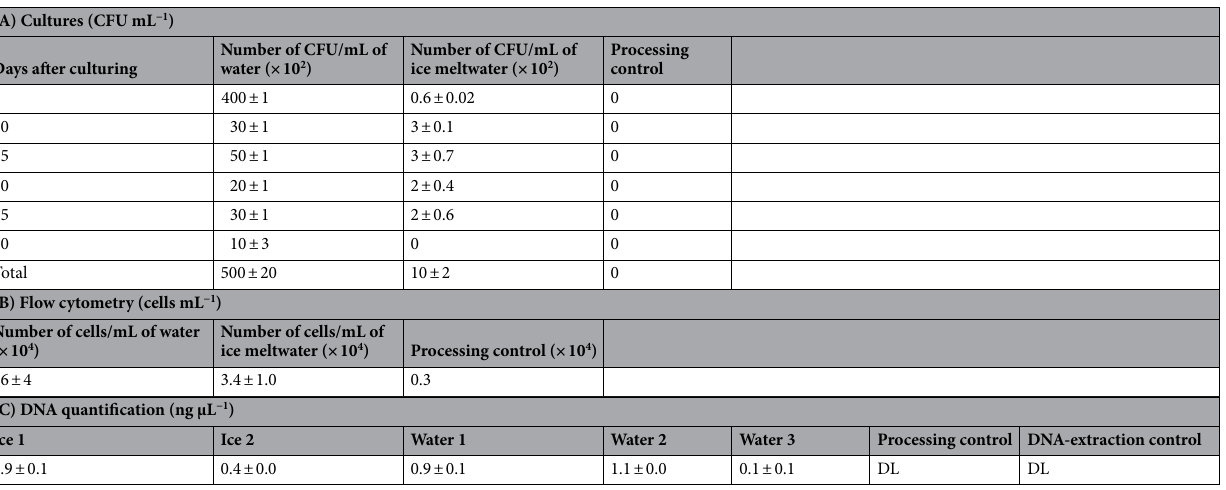
Table 1. Cultures results ( A ) and flow cytometry results ( B ) are presented in average colony-forming units (CFUs) and cells per mL, respectively, of water (interface water), melted environmental ice cores (ice meltwater), and processing control. Environmental water culture results ( A ) and flow cytometry results ( B ) were partially adapted from Coelho et al. (2022) 28 on the same ice cores. (C) DNA quantification (ng/µL) results on environmental water and ice and the processing control based on fluorescence (Qubit fluorometer). CFU colony-forming unit, DL Below detection